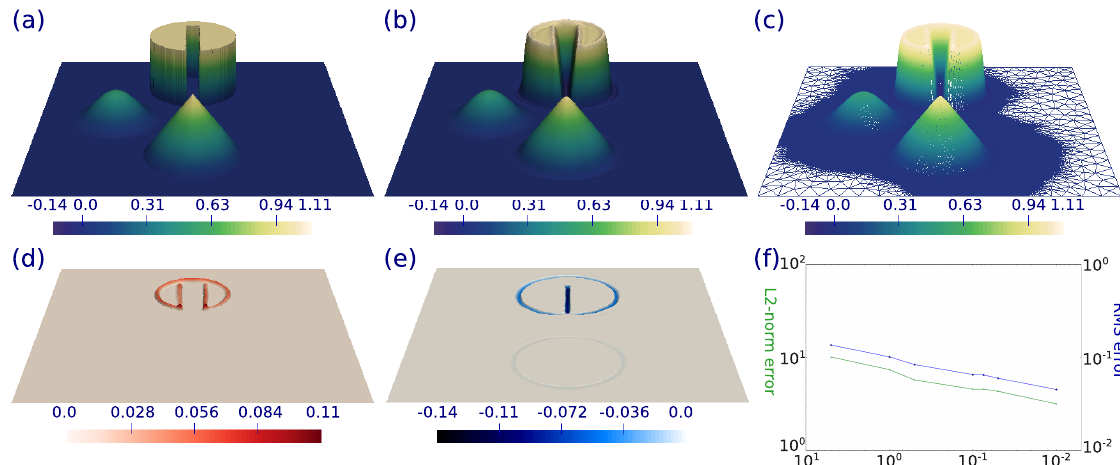
Figure 6. Results of 2-D three body rotation test for refinement time step 0 . 1 π s. (a) Initial condition, (b) solution after one full rotation and (c) solution after one full rotation on the underlying mesh. (d) Overshoots (values greater than maximum initial value, as deviation from max (c initial ) = 1 . 0) and (e) undershoots (values smaller than minimum initial value, as deviation from min (c initial ) = 0 . 0) at t total . (f) Results of the convergence test as a function of mesh refinement parameter c vol . Colour scales show concentration values.